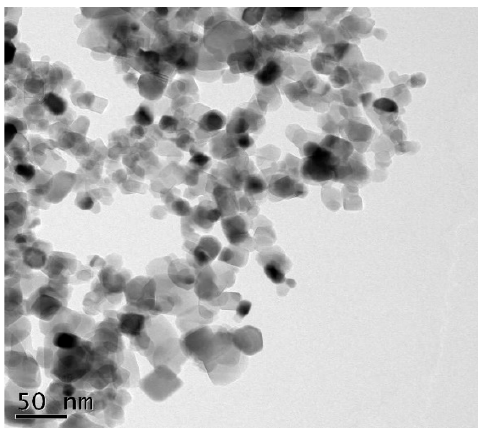
Figure 2. TiO 2 NP under TEM with a magnification of roughly 50 nanometres.